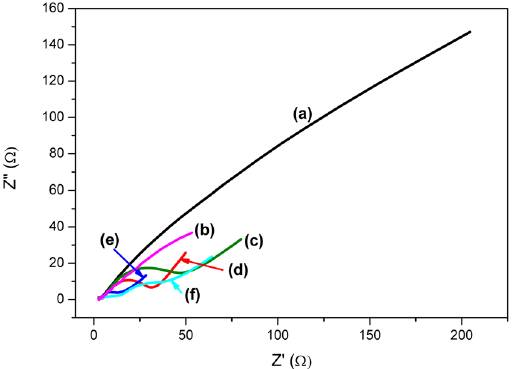
Figure 12. Nyquist plots of ( a ) platelet-like BiVO 4 , ( b ) 3-2 Bi:Ti (PM), ( c ) MIL-125(Ti), ( d ) 1–1 Bi:Ti, ( e ) 2–3 Bi:Ti and ( f ) 3-2